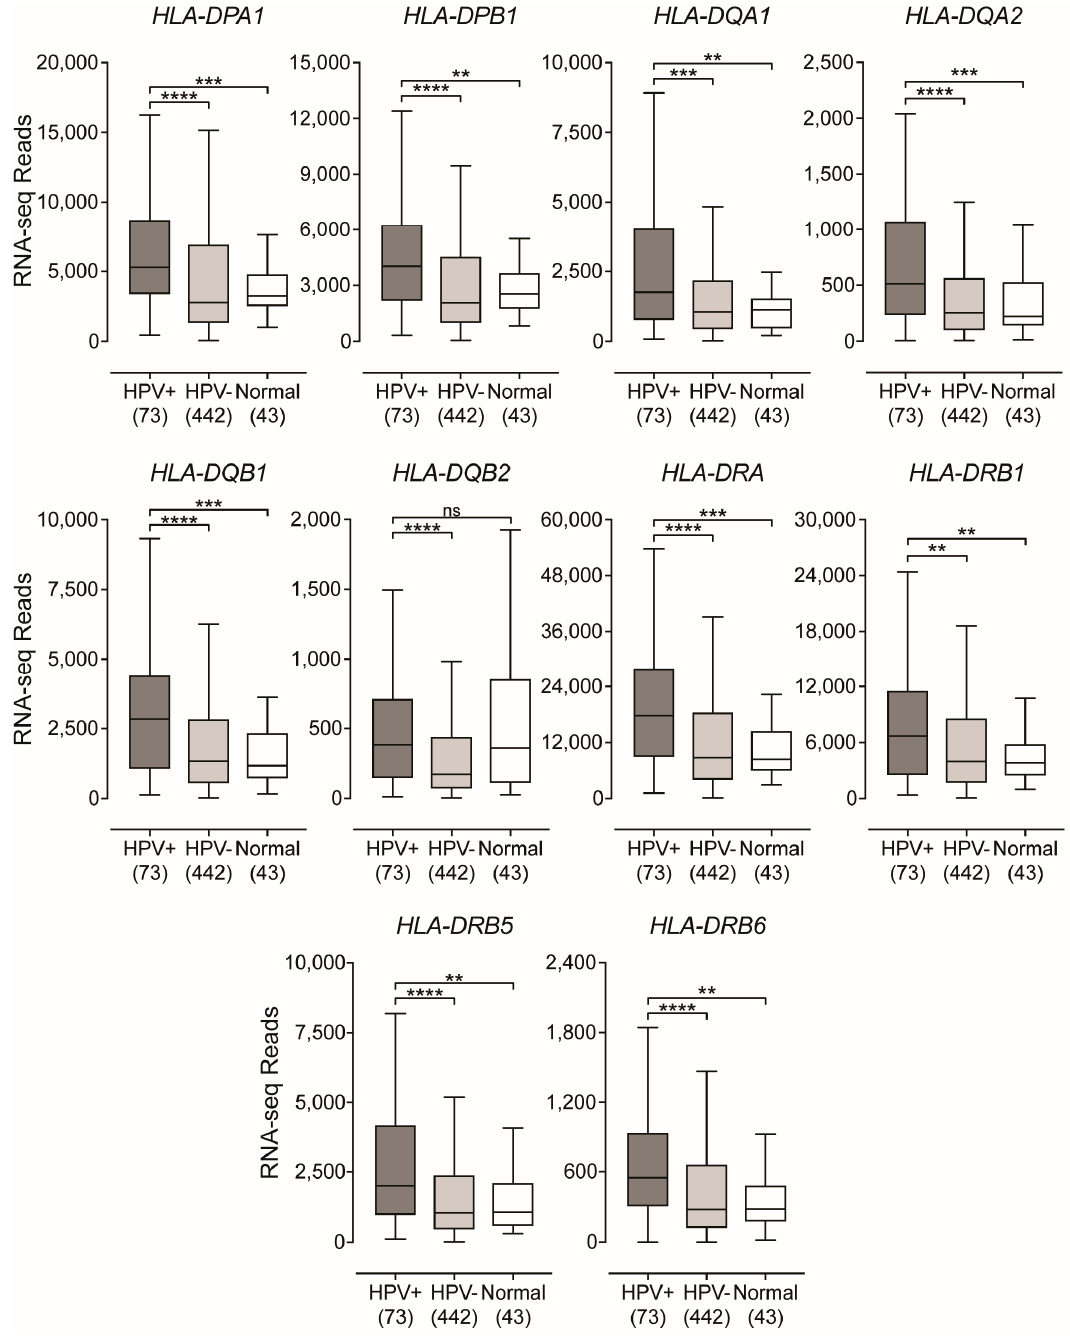
Figure 1. Expression of classical class II major histocompatibility complex (MHC-II) α - and β -chain genes in head and neck squamous cell carcinomas stratified by high-risk human papillomaviruses (HPV)-status. RNA-Seq by Expectation Maximization (RSEM)-normalized RNA-seq data for the indicated MHC-II genes was extracted from The Cancer Genome Atlas (TCGA) database for the head and neck squamous cell carcinoma (HNSC) cohort for HPV + , HPV − , and normal control tissues. Numbers in brackets refer to the number of samples included in each analysis. Statistical analysis was performed using a two-tailed non-parametric Mann–Whitney U test. * p ≤ 0.05, ** p ≤ 0.01, *** p ≤ 0.001, **** p ≤ 0.0001, ns—not significant.